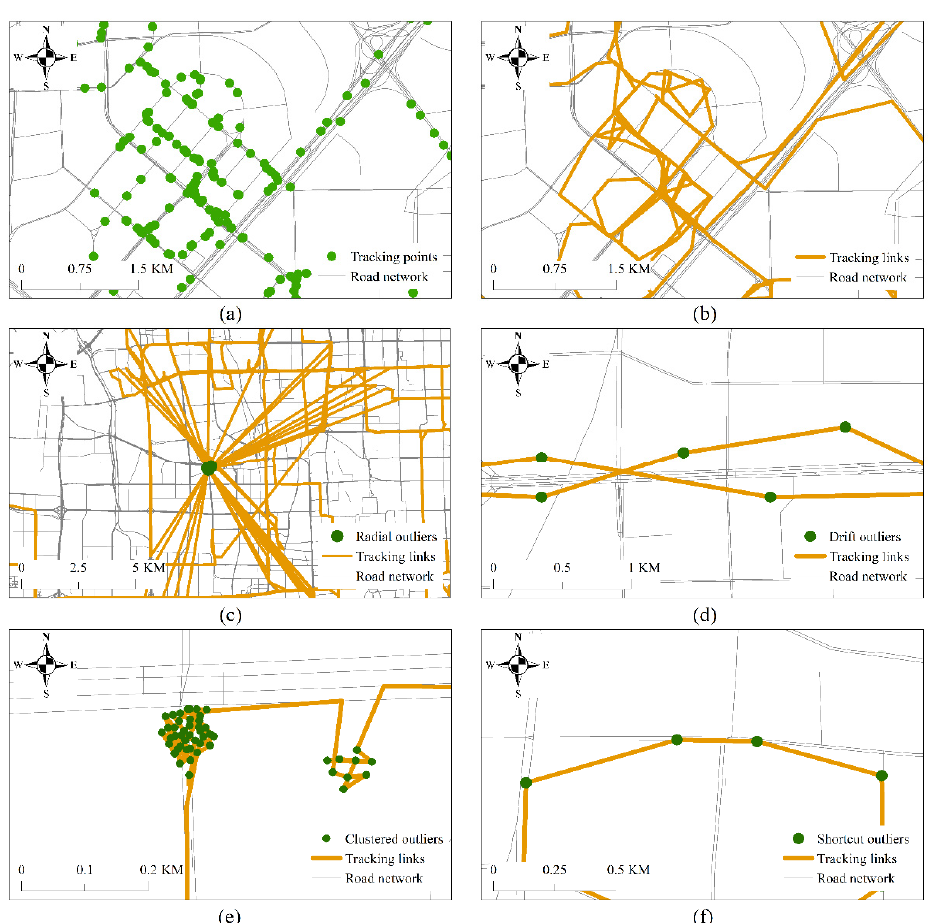
Figure 1. Four types of outlier tracking links (tracking points, tracking links, radial outliers, drift outliers, clustered outliers, and shortcut outliers are shown in ( a ), ( b ), ( c ), ( d ), ( e ), and ( f ), respec- tively).